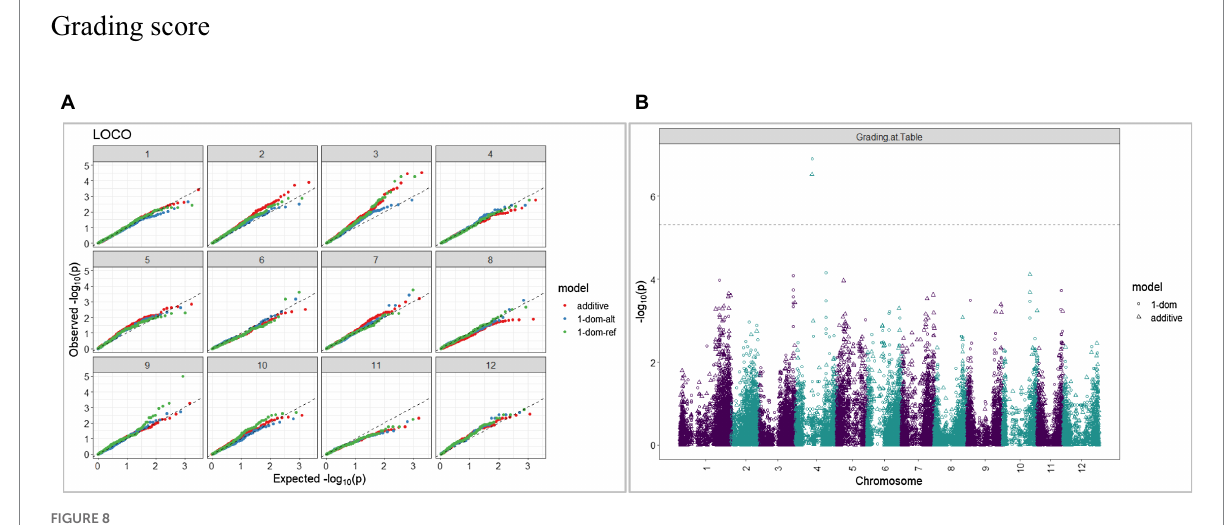
FIGURE 8 Q–Q plots of observed vs. expected -log10 ( p values) ( A ) and corresponding Manhattan plot (B) for grading score using the additive and dominant model in three combined environments for tuber traits of 214 potato clones evaluated in three environments in Texas: Dalhart 2019, 2020 and Springlake 2020. The Bonferroni threshold was at 5.3 for the additive, 5.0 for 1-dom-alt, and 5.1 for the 1-dom-ref model.